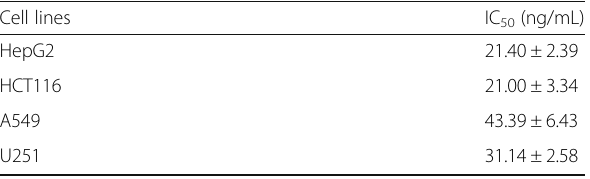
Table 1 IC 50 values of BF/PEG-LP for cancer cell lines Cell